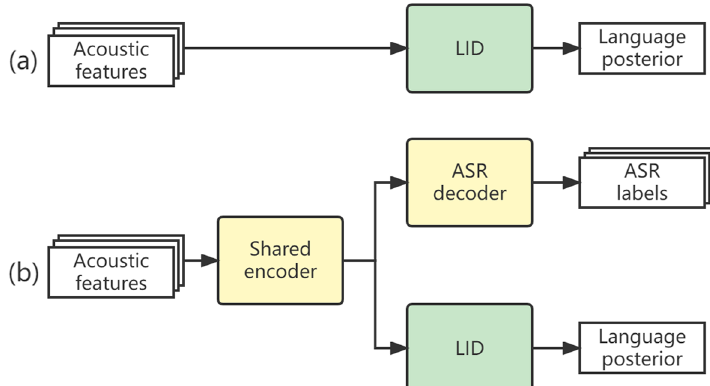
Fig. 1 a The end-to-end LID architecture. It directly gets utterance-level LID decisions from frame-level acoustic features. b The ASR-LID parallel branches architecture. The shared encoder trained with ASR-loss can produce frame-level phonetic information, which helps to improve the LID performance dramatically